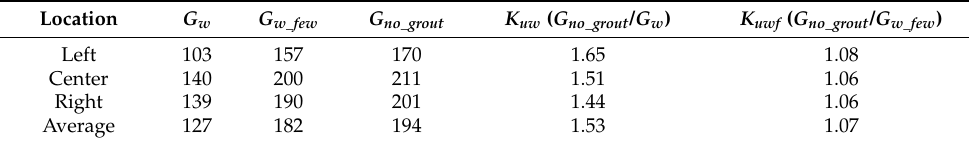
Table 3. Gray values and K ratios for Figure 26. 200 mm by 950 keV, grout is not filled.